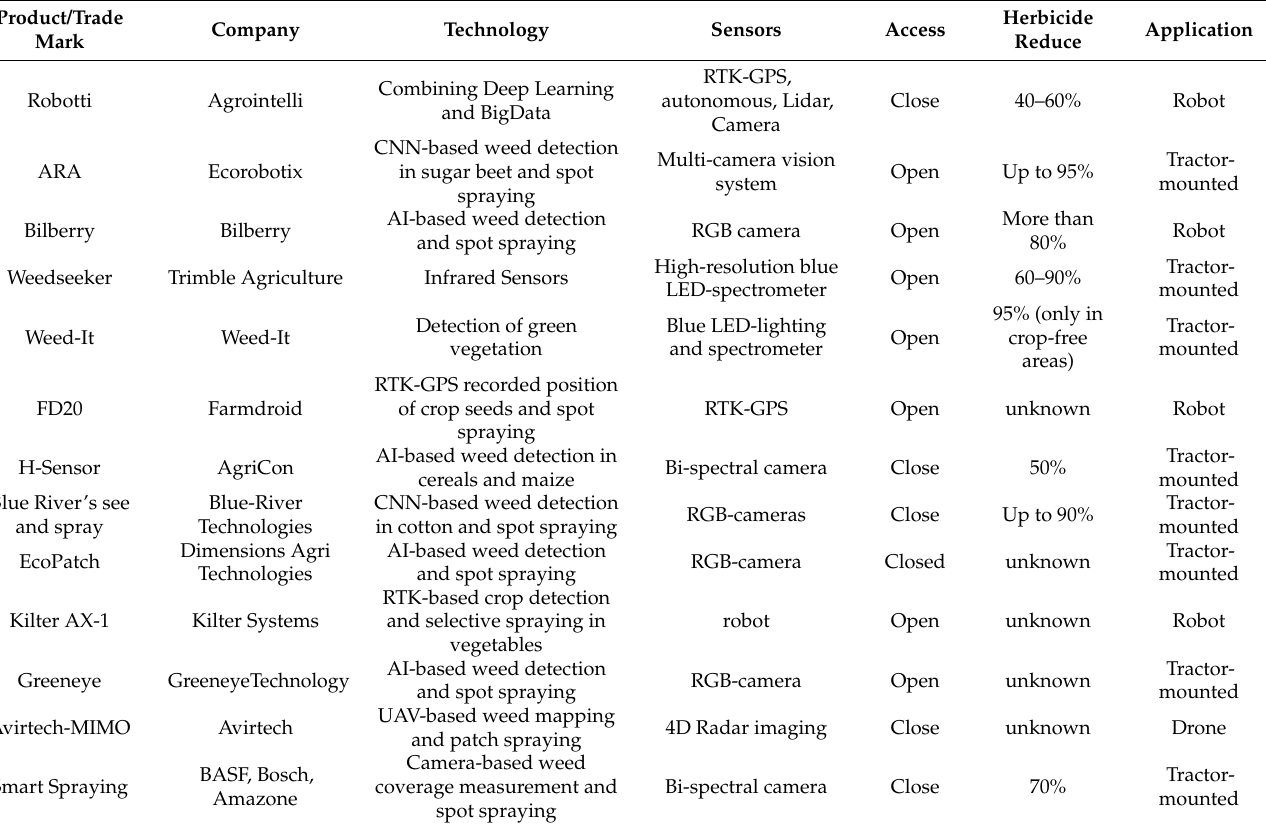
Table 1. Overview of commercially available Spot Spraying systems with the currently used technol- ogy, the sensors, the access, the application and the possible herbicide